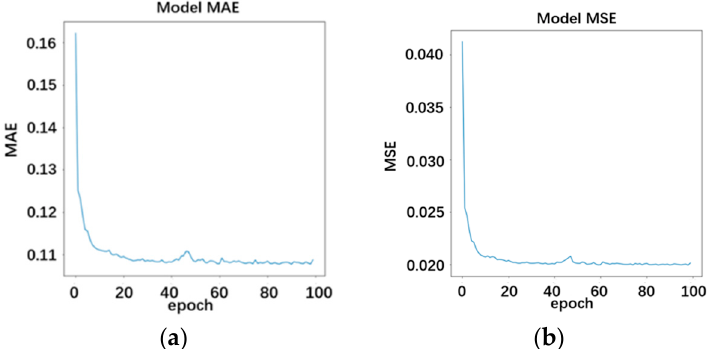
Figure 10. Model error of 4 h simulation data as training data: ( a ) model MAE; ( b ) model MSE.